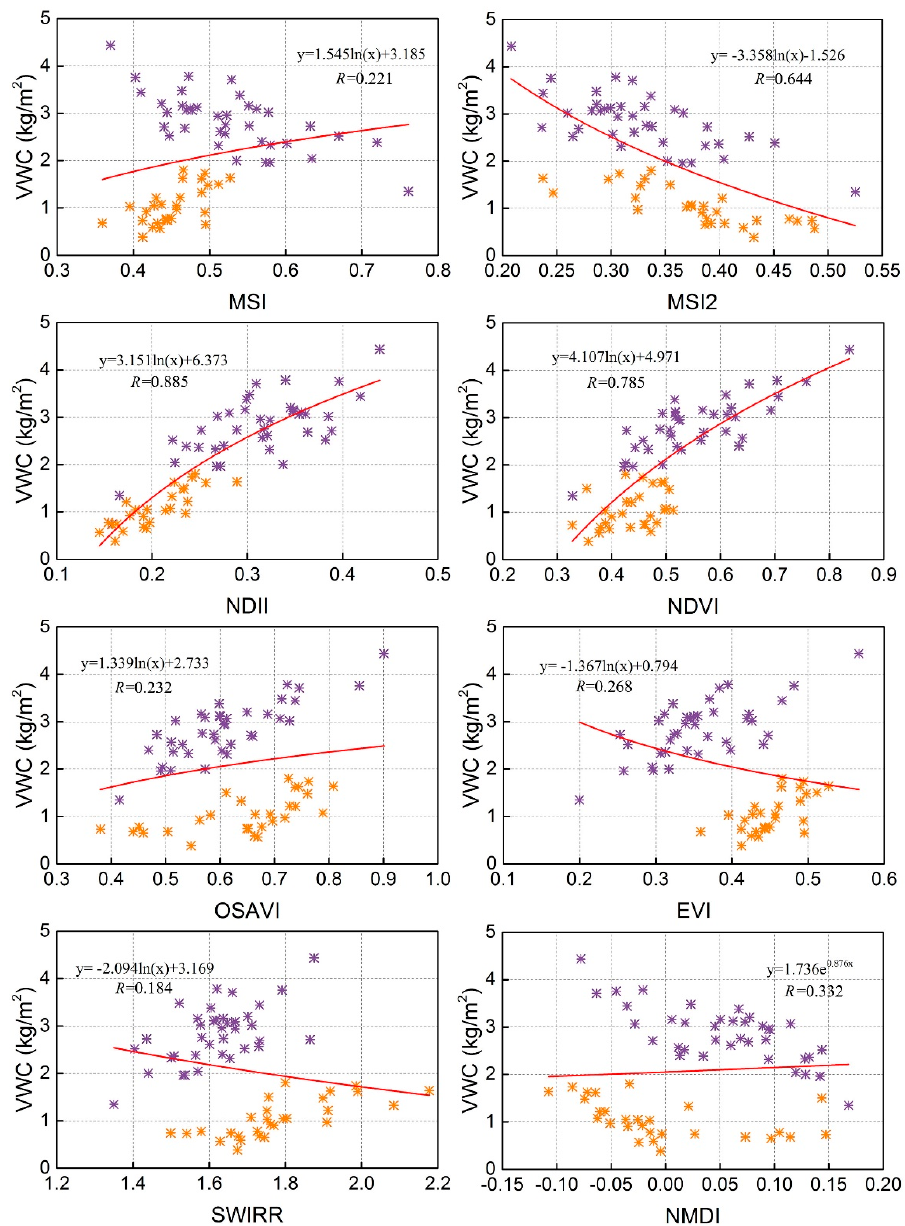
Figure 4. Relationships between different vegetation water indices from Landsat-8 data and measured VWC (the purple sampling points are wheat and the orange sampling points are corn). Table 3. Error metrics of vegetation water content (VWC) derived from different vegetation water indices.